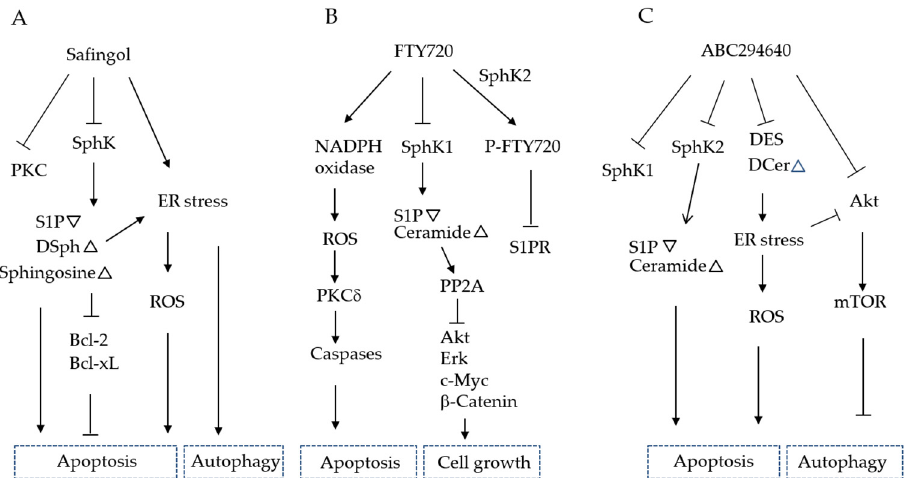
Figure 3. Proposed signaling pathways affected by SphK inhibitors. ( A ) Safingol inhibits SphK, and increases sphingosine and dihydrosphingosine (DSph), but not ceramide. These increased sphingolipids may induce ER stress and ROS production, leading to apoptosis and/or autophagy. ( B ) FTY720 is phosphorylated by SphK2, resulting in p-FTY720, which extracellularly inhibits S1PR signaling. Intracellularly, FTY720 inhibits SphK1, activates PP2A, and suppresses Akt, Erk, c-Myc, and β -catenin. FTY720 also activates PKC δ through an NADPH-mediated pathway. ( C ) ABC294640 inhibits SphK2, and induces proteasomal degradation of SphK1 and dihydroceramide desaturase (DES). Accumulated dihydroceramide (DCer) can induce ER stress, up mark(triangle), increase by the SphK inhibitor, and down mark (inverted triangle), decrease by the SphK inhibitor.